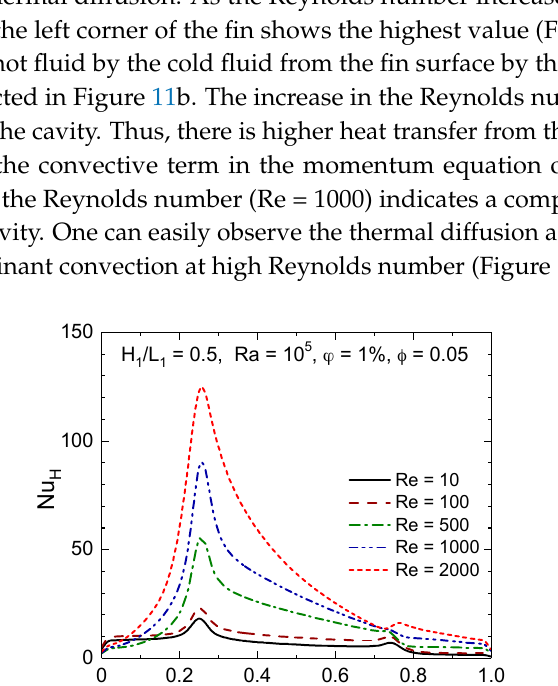
Figure 11. Dimensionless velocity contours for three different Reynolds number for H 1 / L 1 = 0.5 and Ra = 10 5 for the fin area fraction of 0.05 and an Al 2 O 3 -volume fraction of 1%. ( a ) Re = 100; ( b ) Re = 500; ( c ) Re = 1000.